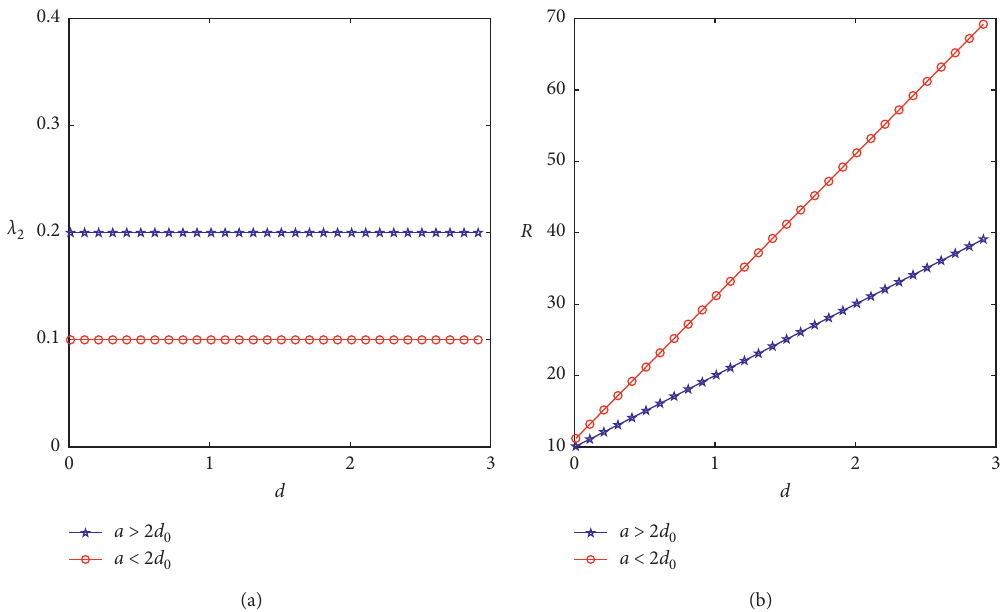
Figure 4: When N is odd, the synchronizability of Network I changes with the interlayer coupling strength d of the leaf nodes. (a) λ with d ( d changes from 0.01 to 3); (b) R changes with d ( d changes from 0.01 to 3).